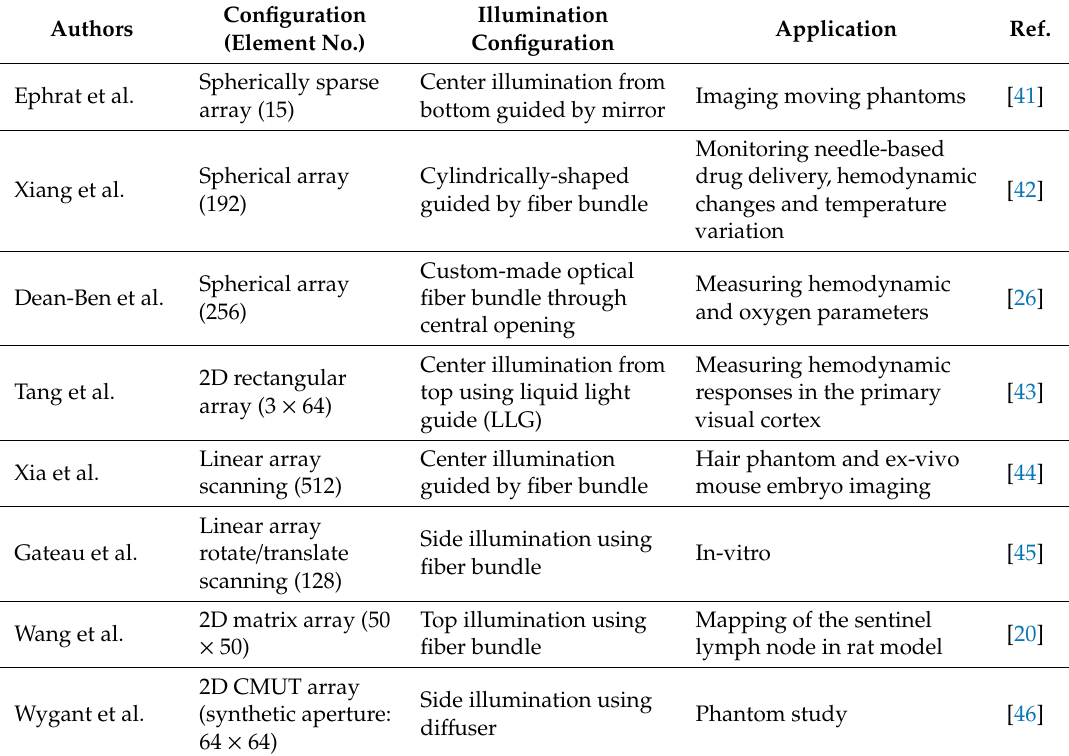
Table 1. Di ff erent 3D PA signal detection